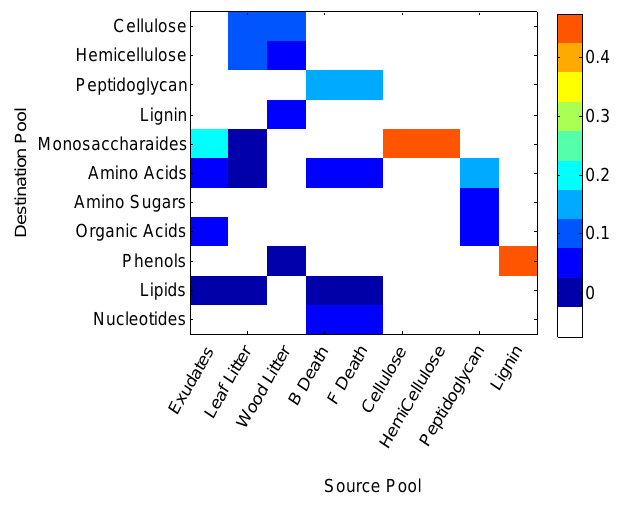
Figure 2. Partitioning of the various carbon source pools into the eleven SOM destination pools. The values in each column sum to 1.0; each value indicates the fraction of the source pool allocated to a particular destination